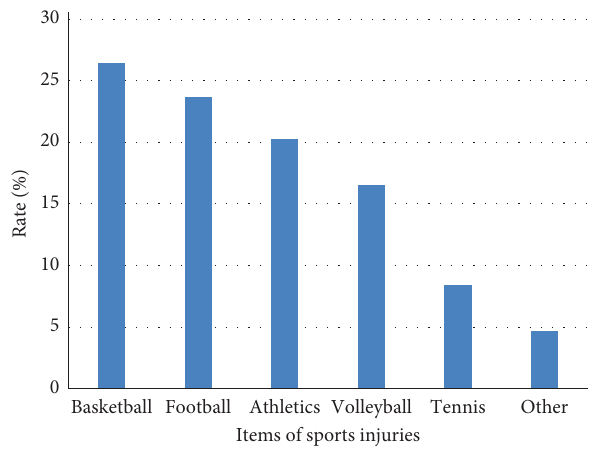
Figure 6: Items of sports injuries in students.